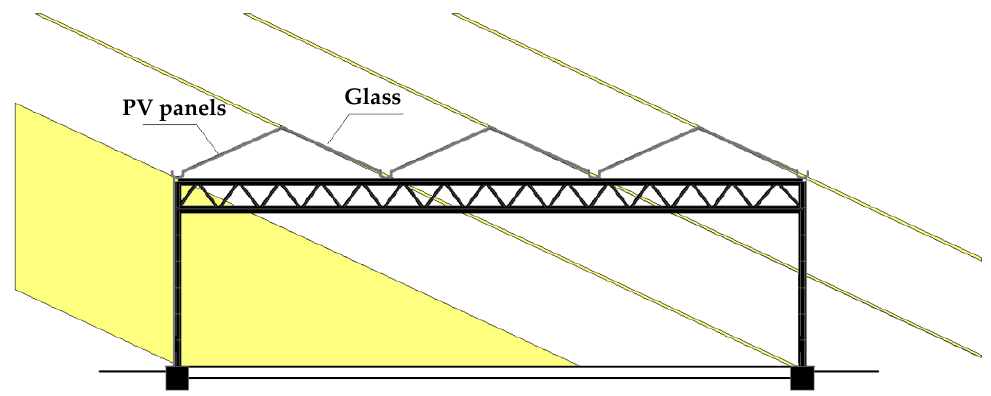
Figure 4. Direct solar radiation at Mediterranean latitudes: 21 December, 12:00 pm.